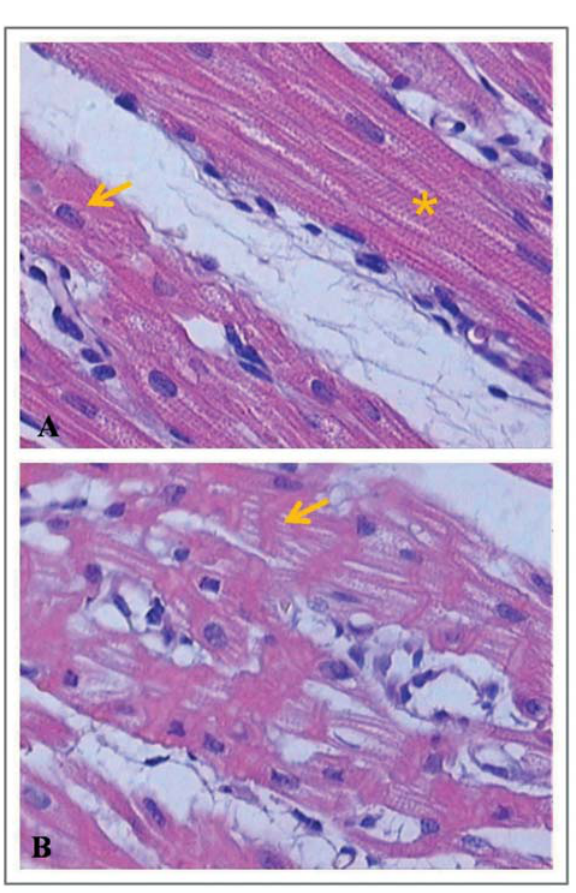
Fig. 2 – Comparação pós-operatória entre subgrupos do grupo II quanto às variáveis hemodinâmicas. IIA – sem perfusão do tronco pulmonar; IIB – perfusão do tronco pulmonar com sangue arterial; vascular pulmonar em dyne.s.cm